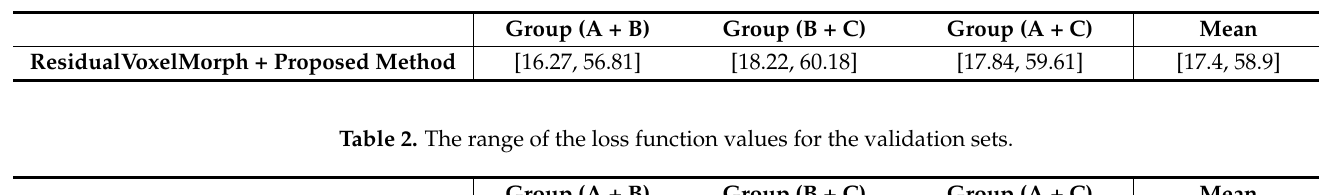
Table 1. The range of the loss function values for the training sets.